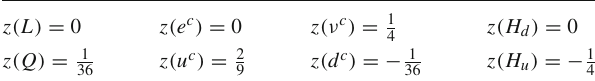
Table 1 U ( 1 ) (cid:2) charges of the SM matter within the U μν SSM scenario